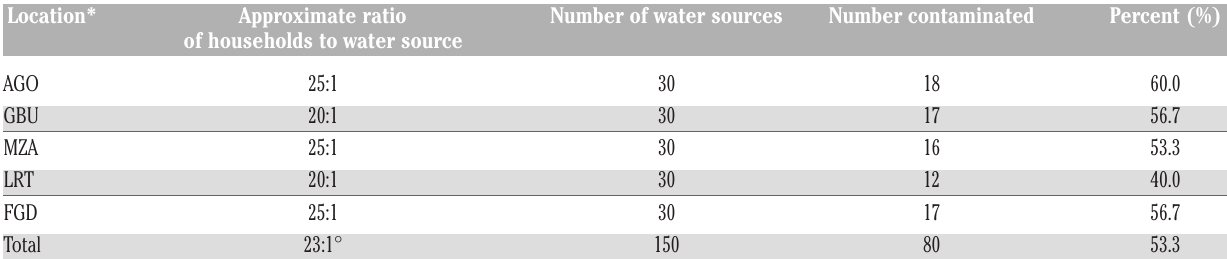
Table 2. Distribution of contaminated water sources according to location.